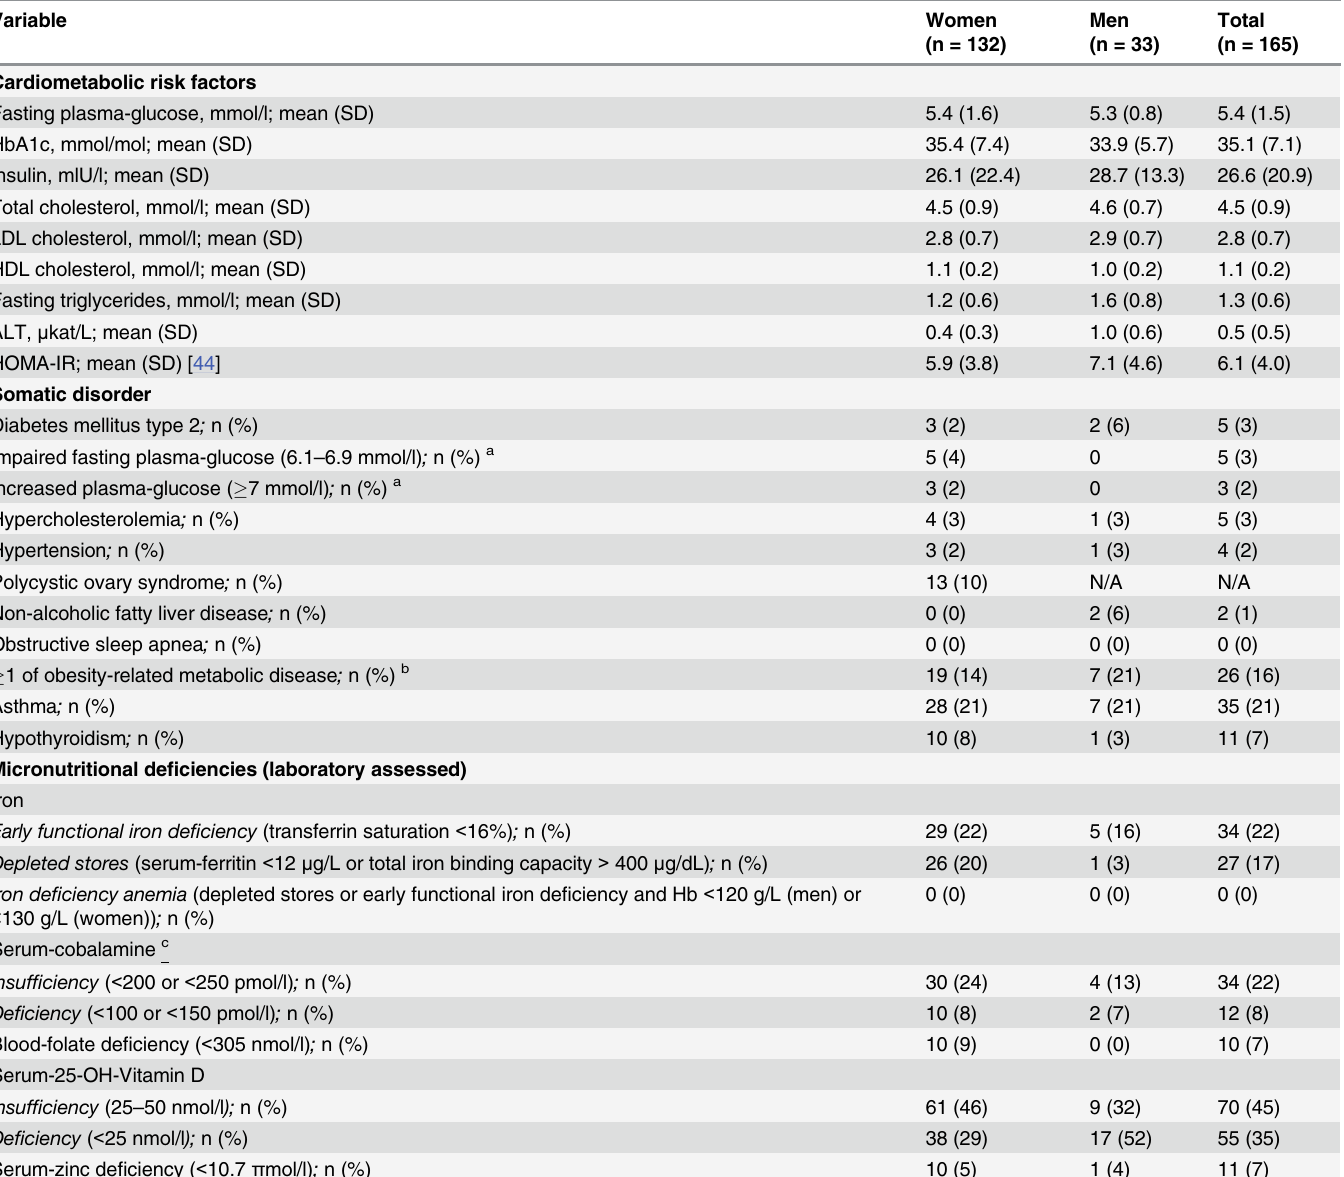
Table 2. Cardiometabolic risk factors, somatic disorders and micronutritional deficiencies in n = 165 treatment-seeking young adults (16 – 25 y) with obesity. Variable Cardiometabolic risk